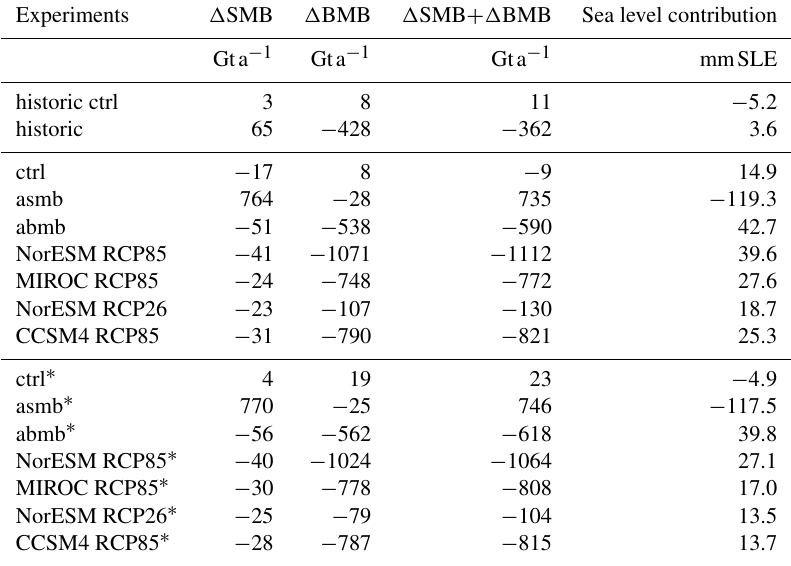
Table 1. Mass loss and evolution of surface and basal mass balance in ISMIP6 simulations. All values, except for the ctrl simulations, are relative to the respective control simulation.